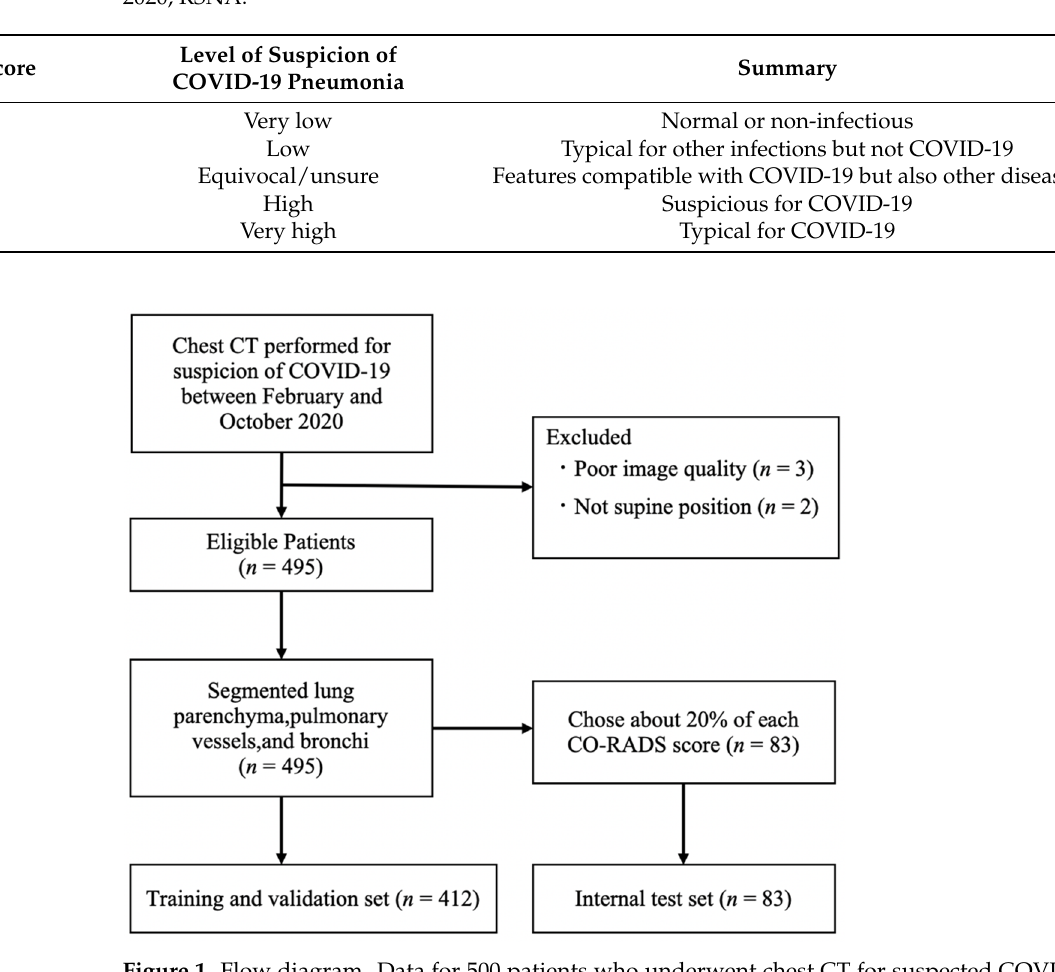
Figure 1. Flow diagram. Data for 500 patients who underwent chest CT for suspected COVID-19 pneumonia were collected. After exclusion, 495 eligible patients were included in the model devel- opment and evaluation. The dataset was classified into a training set ( n = 412) and an independent patient-level test set ( n = 83). The proportion of images with different CO-RADS scores in the test set was equivalent to that in the training set. CO-RADS; COVID-19 Reporting and Data System.